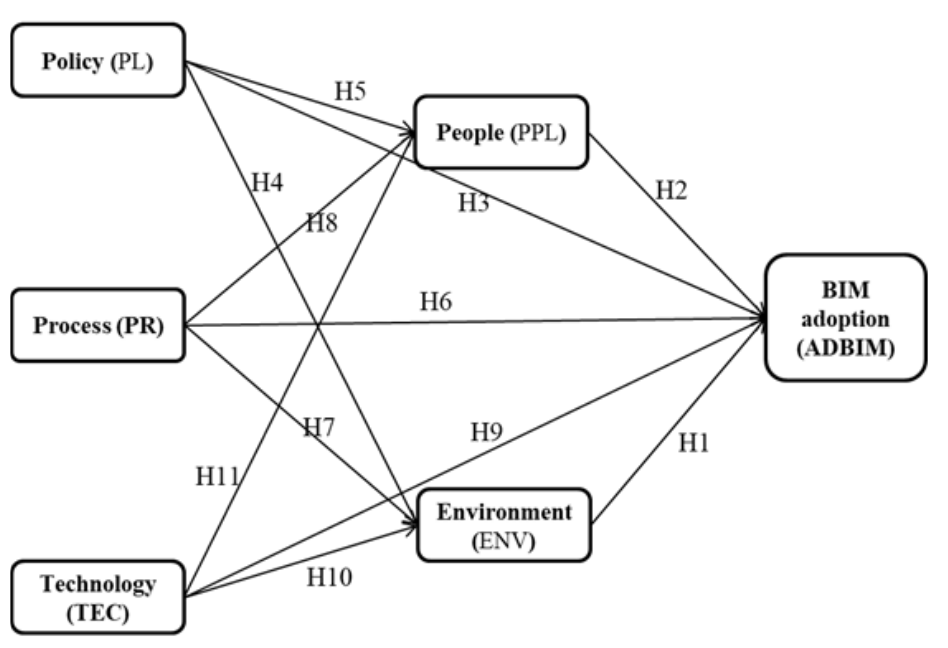
Figure 2. The hypotheses of the research.